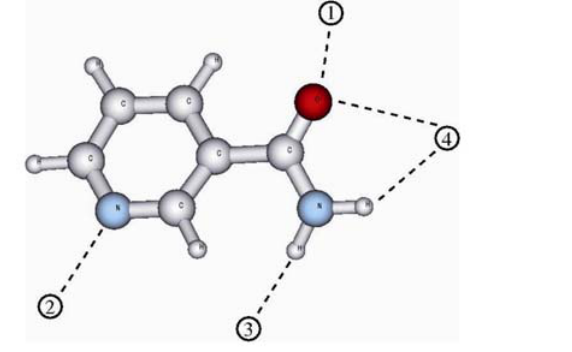
Figure 8. The possible binding sites for the functional monomer MAA to the nicotinamide template